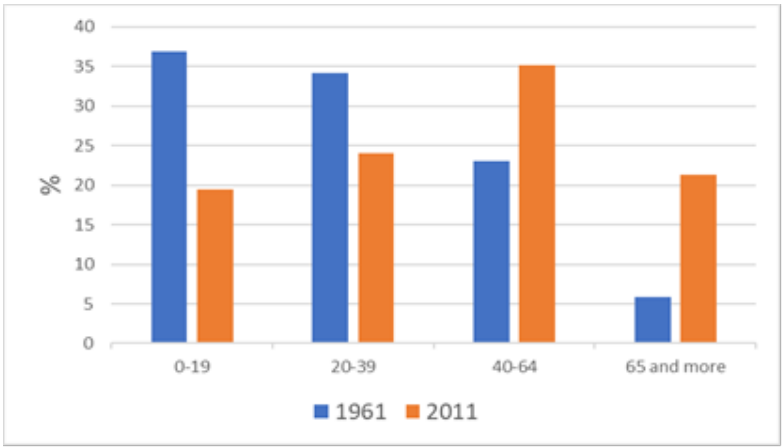
Figure 4. Population of rural settlements in the Jablanica River Basin by age group in 1961 and